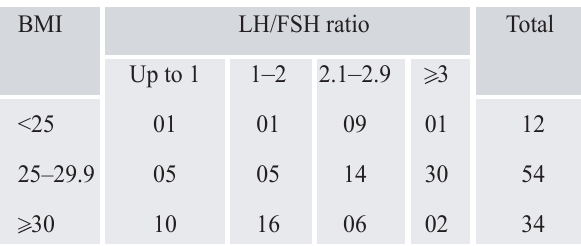
Table II: Distribution of study subjects with BMI and LH/FSH ratio